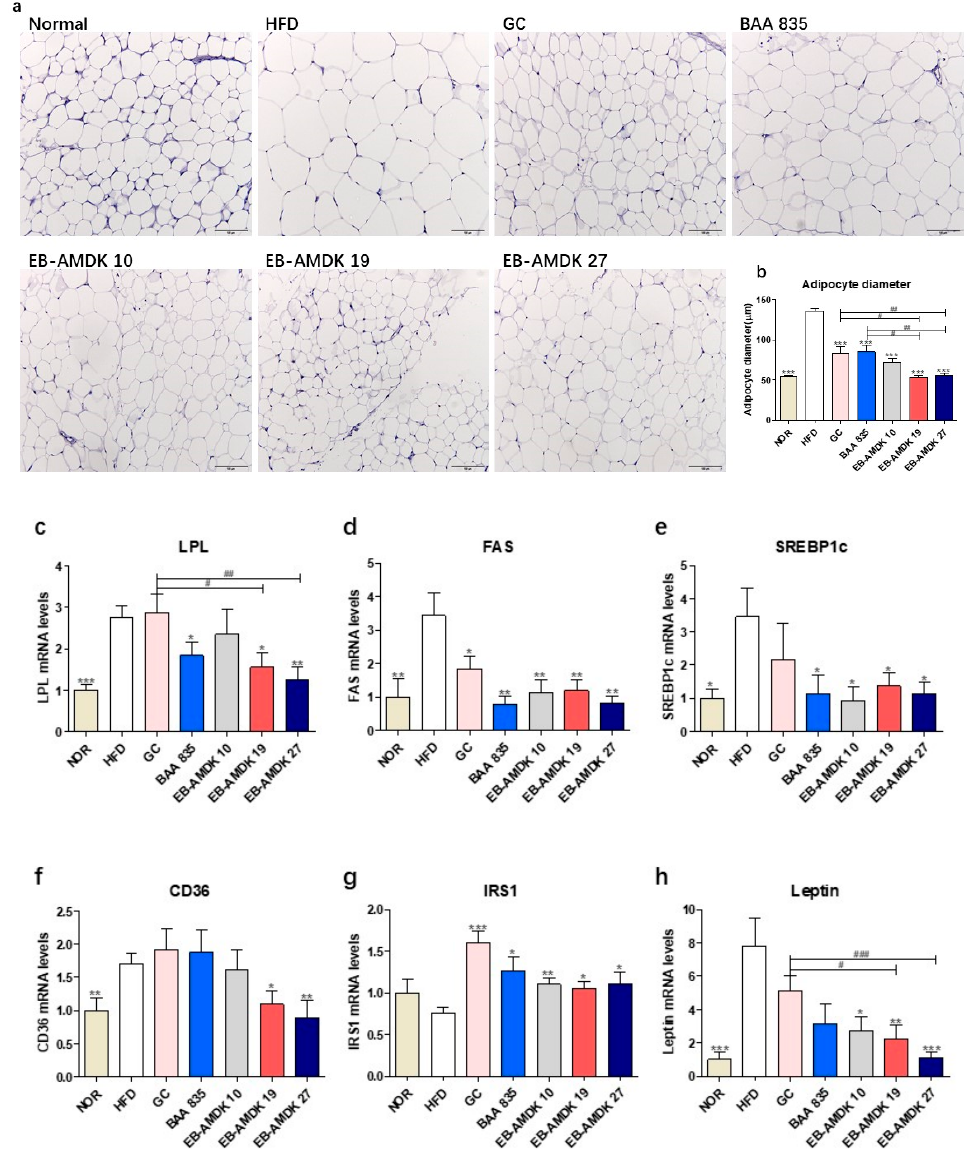
Figure 5. Effects of A. muciniphila on the adipokine profile of adipose tissue in HFD-fed mice. ( a ) Histological analysis (H&E staining) on sections of mesenteric fat tissues ( n = 3 per condition, scale bar, 100 µm). ( b ) Average diameters of adipocytes in randomly chosen fields were measured and presented as pixels using Image-Pro Plus 6.0. ( c ) LPL, ( d ) FAS, ( e ) SREBP1c, ( f ) CD36, ( g ) IRS1 and ( h ) Leptin mRNA levels in the adipose tissues ( n = 9–12). Data are represented as the mean ± SEM. Statistics were performed with one-way ANOVA or Student’s t-test. * p < 0.05, ** p < 0.01 and *** p < 0.001 versus the HFD group. # p < 0.05, ## p < 0.01, ### p < 0.001.